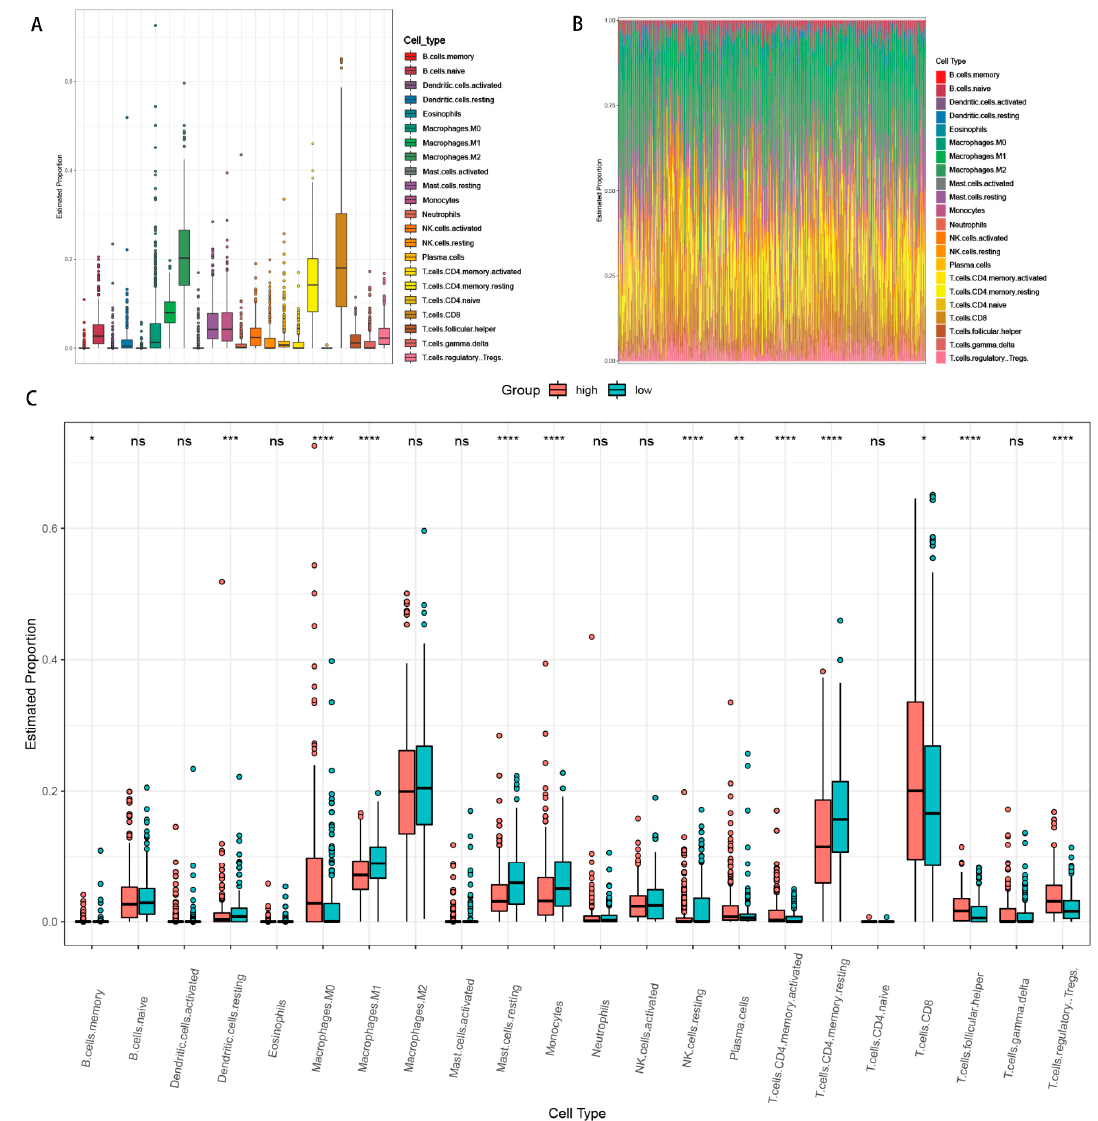
Figure 6. Distribution of immune cells in tumor microenvironment in the TCGA cohort. ( A ) Each type of immune cell accounts for information in the tumor microenvironment. ( B ) The proportion of immune cells in each patient in the TCGA cohort. ( C ) The difference in the proportion of immune cells between the high-risk group and the low-wind group. *: p < 0.05; **: p < 0.01; ***: p < 0.001; ****: p < 0.0001; ns: no significance.